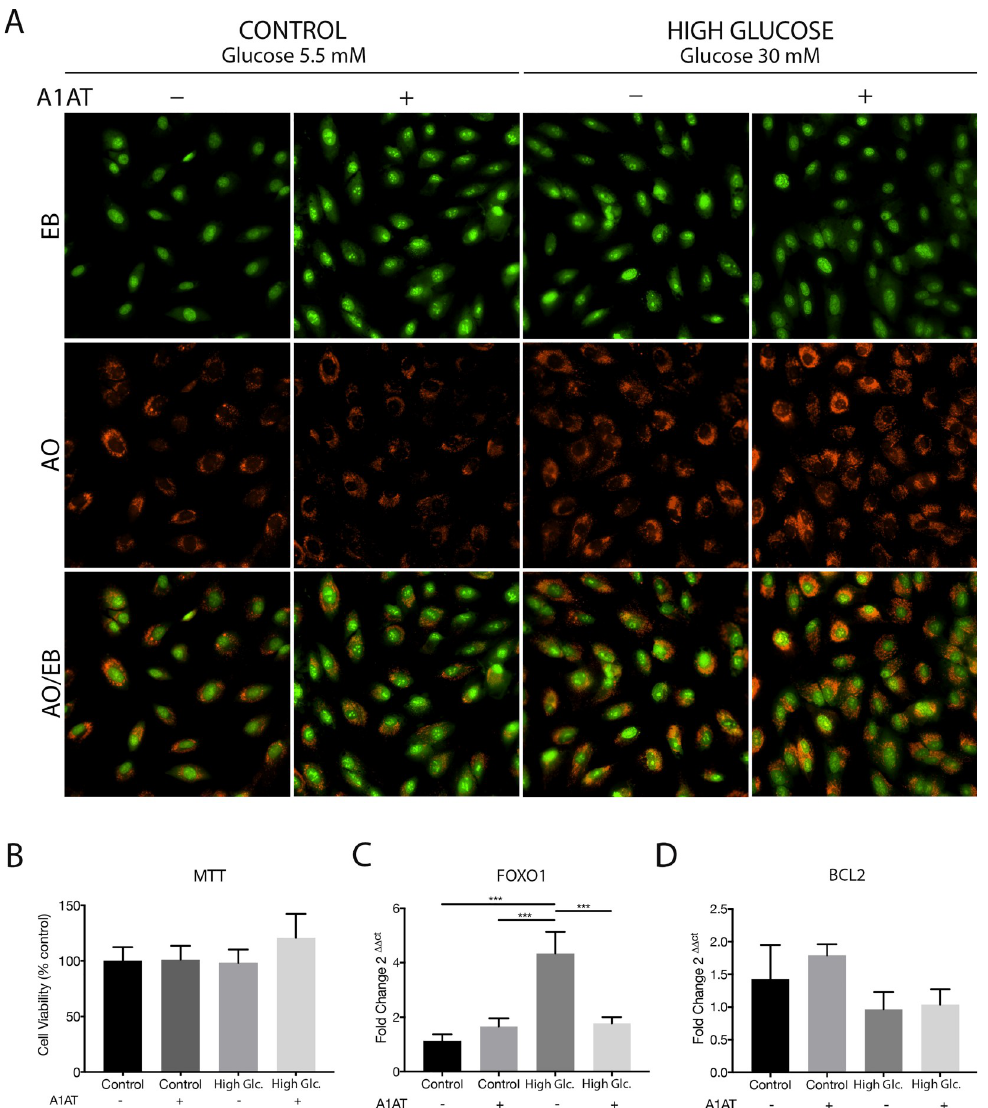
Fig 1. Viability of ARPE-19 cells treated with high glucose (High Glc.) and with A1AT. (A) Representative microphotographs of AO/EB staining assay in different cell culture conditions, total magnification 400X (10X ocular lenses and 40X objective). (B) Viability determined with MTT assay. Data expressed as percentage of control cultures, mean ± SD (n = 5). (C) FOXO1 and (D) Bcl2 mRNA expression levels measured with RT-qPCR. Data expressed as fold change with respect to control. ��� p < 0.001 vs.